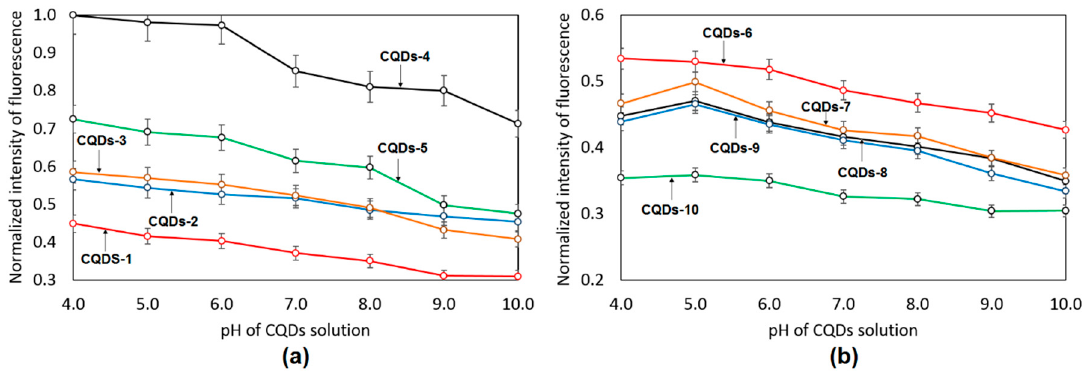
Figure 4. Fluorescence spectra of the prepared carbon quantum dots depending on pH value: ( a ) samples CQDs-1–CQDs-5; ( b ) samples CQDs-6–CQDs-10.